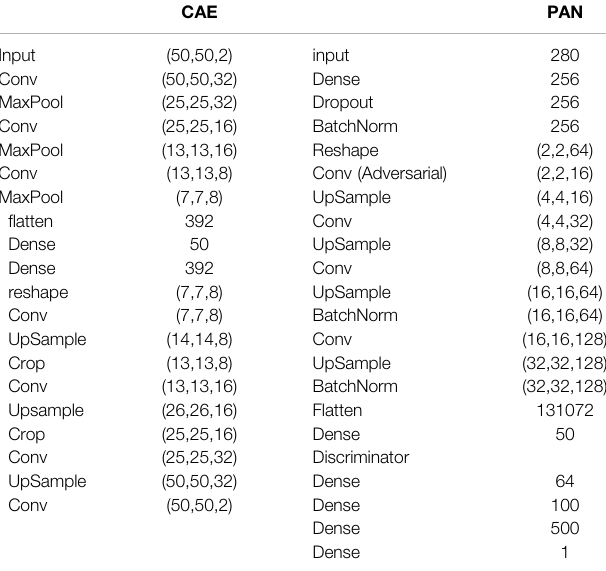
Frontiers in Physics |